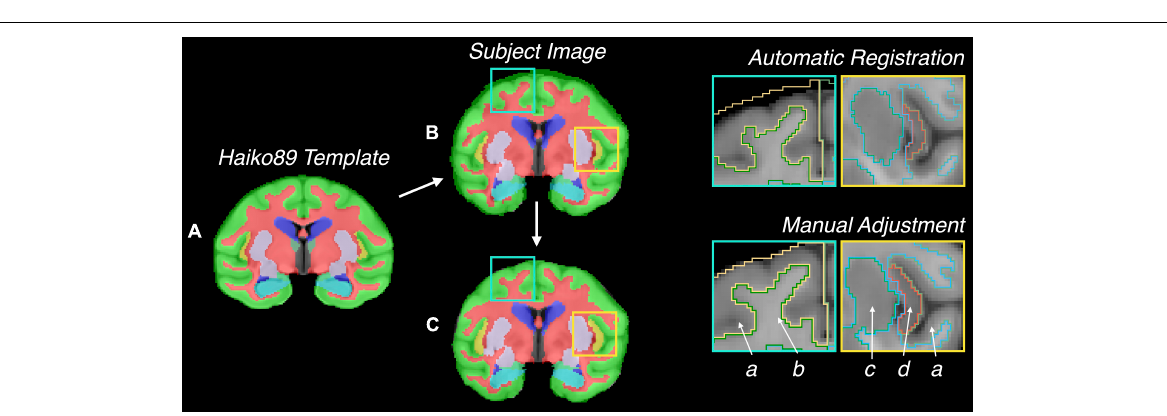
Frontiers in Neuroanatomy |